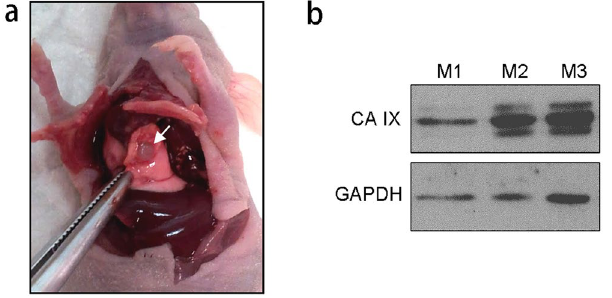
Figure 5. Establishment of orthotopic NSCLC tumor models. ( a ) Representative solitary tumor surrounded by normal lung tissue that was observed 56 days after intrathoracic injection of A549 cells; ( b ), Western blot detection of CA IX in A549 lung tumor xenografts collected from three individual mice (M1, M2, and M3). GAPDH was used as the loading control.